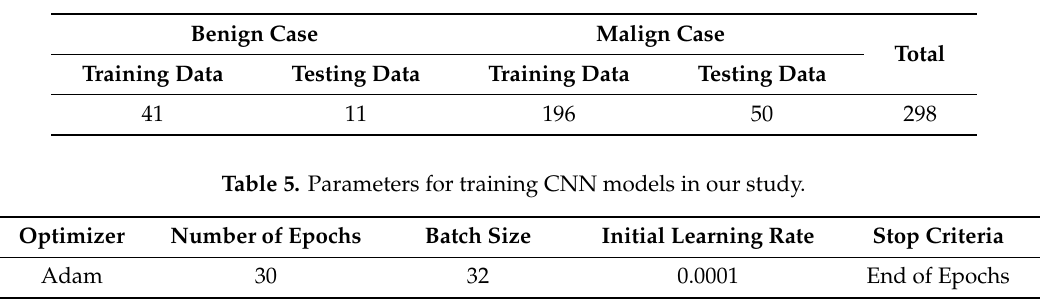
Table 4. Description of the TDID dataset used in our experiments (each number means the number of patients).